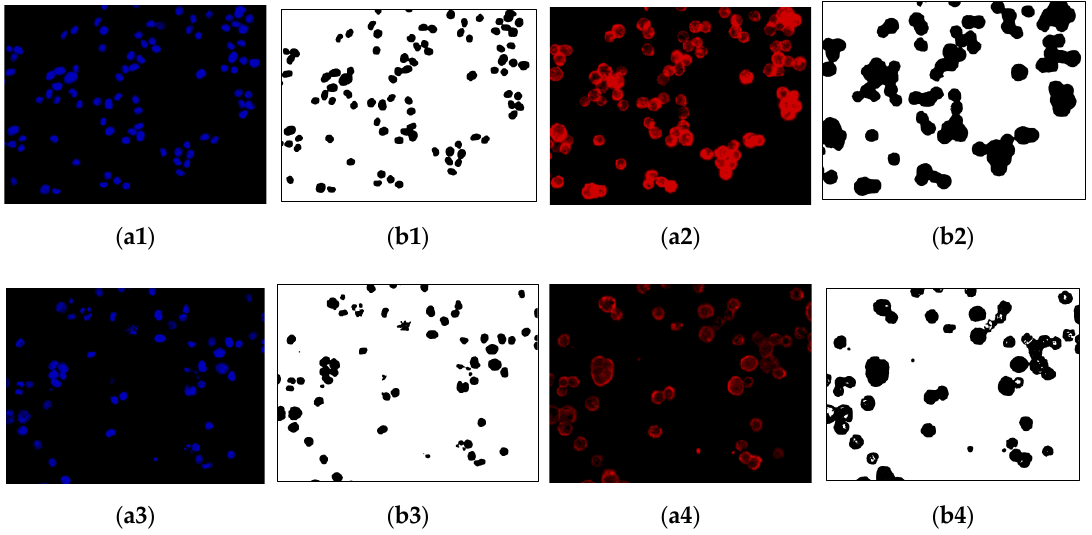
Figure 13. Image color quantization and background removal: ( a1 ), ( a3 ) color quantization of the nucleus images; ( a2 ), ( a4 ) color quantization of the cytoskeleton images; ( b1 ), ( b3 ) nucleus regions ( N ); ( b2 ), ( b4 ) cytoskeleton regions ( C ).